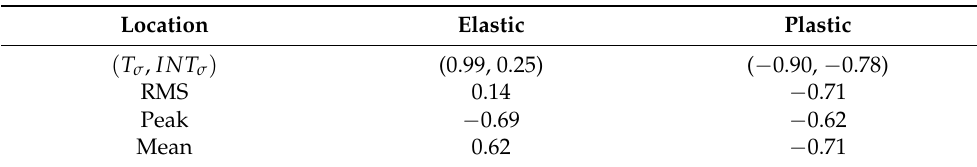
Table 4. The correlation among RMS, mean, peak, MBN transient analysis eigenvalue fusion ( T σ , INT σ ) and stress (strain) of